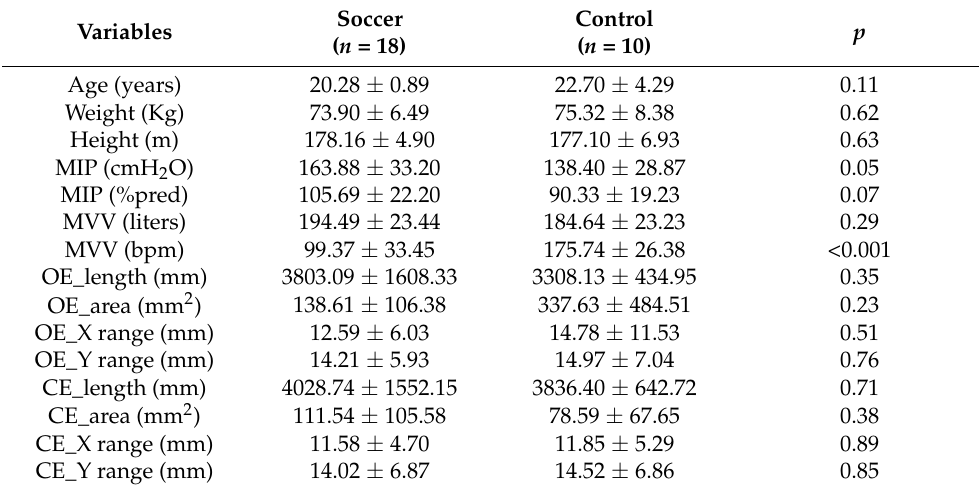
Table 1. General characteristics of the participants. Variables